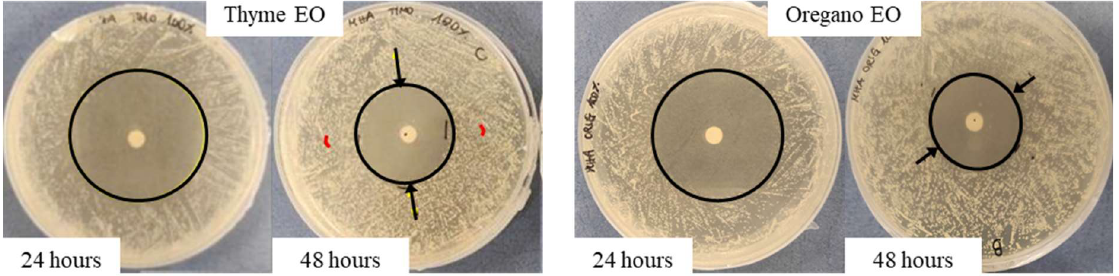
Figure 2. Variation of the inhibition halo diameter from 24 to 48 h, for the disk diffusion test, in the presence of 100% thyme or oregano EO, against S. epidermidis . Arrows indicate the variation direction.